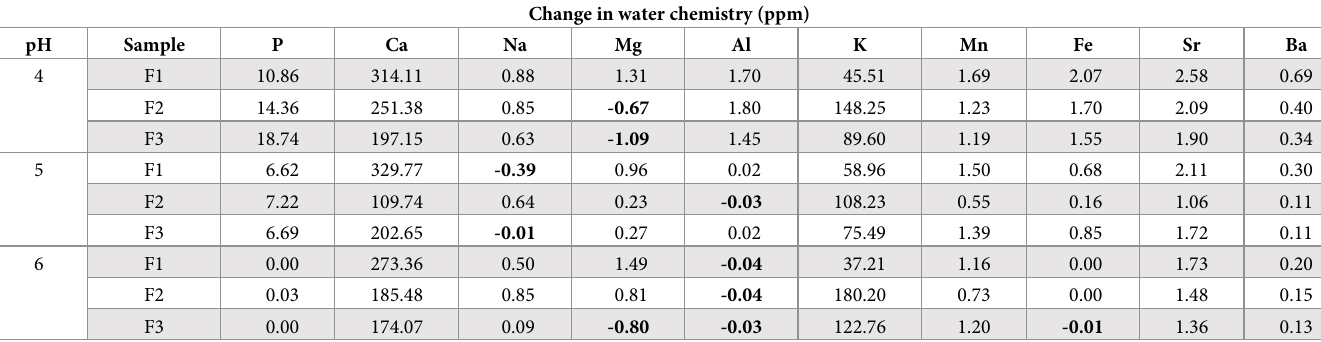
The bold values represent elemental depletions in the post-dissolution water chemistry.